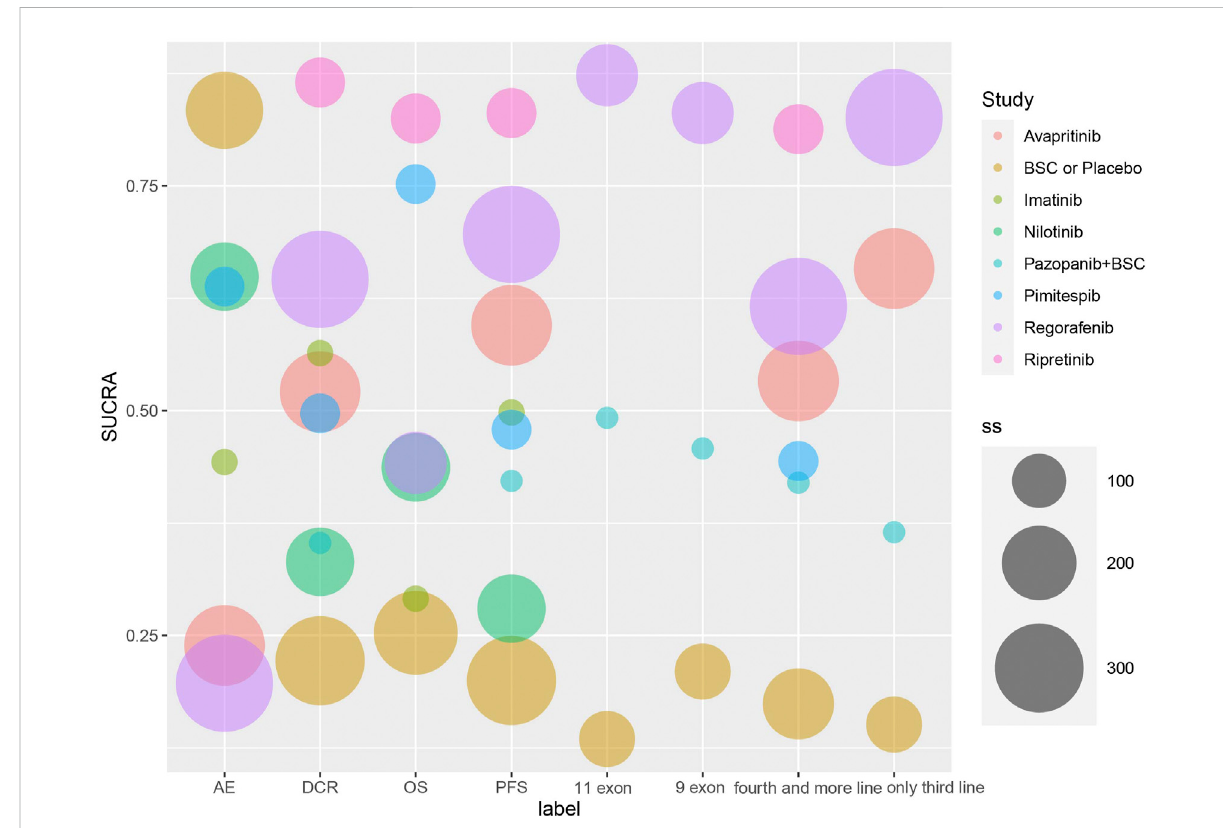
FIGURE 4 SUCRA score of each targeted agent in all outcomes. The sizes of each circle are weighted by the patient number.